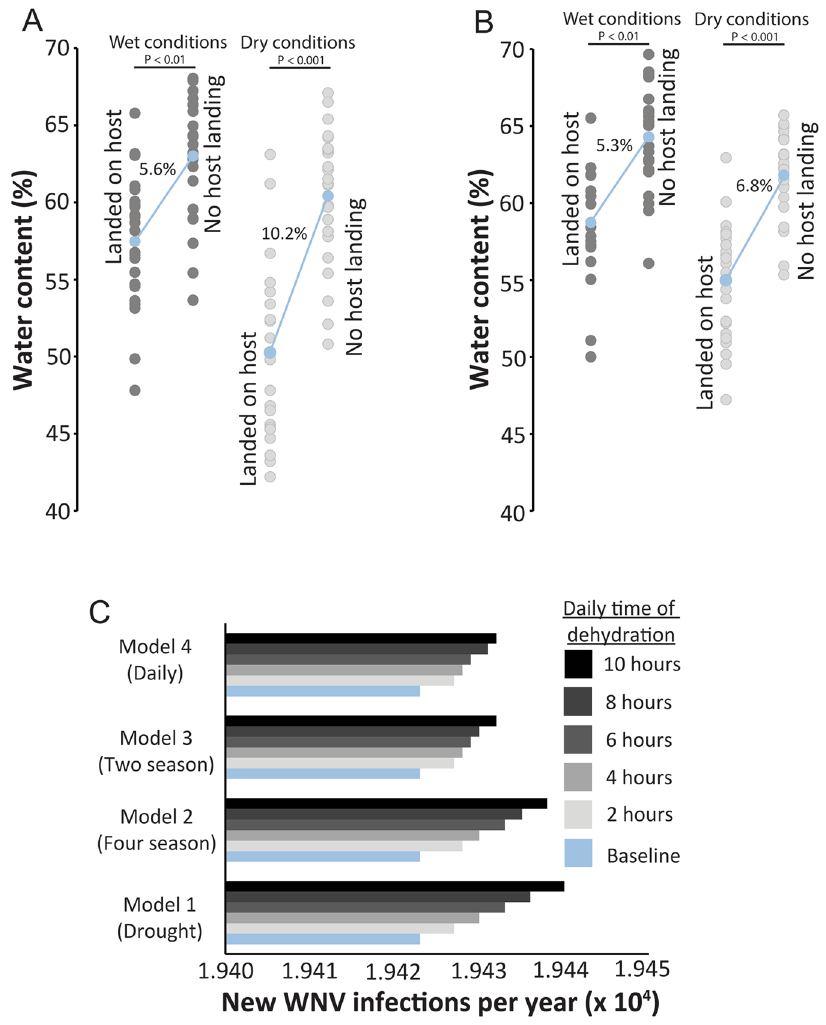
Figure 5. Dry field and laboratory conditions increased host landing and impacted disease transmission based on West Nile virus transmission modeling for C . pipiens females. ( A ) Body water content (% of total mass) assessment of females attempting to blood feed following 24 hours with and without precipitation from field mesocosm studies. Mean ± SE for 8 replicates at each time point. ( B ) Water content of females attempting to blood feed under laboratory conditions. Mean ± SE of 8 replicates at each time point. ( C ) Predicted transmission of WNV will increase as the result of increased blood feeding due to dehydration exposure. Modeling and wet vs. dry conditions described in Supplemental Materials